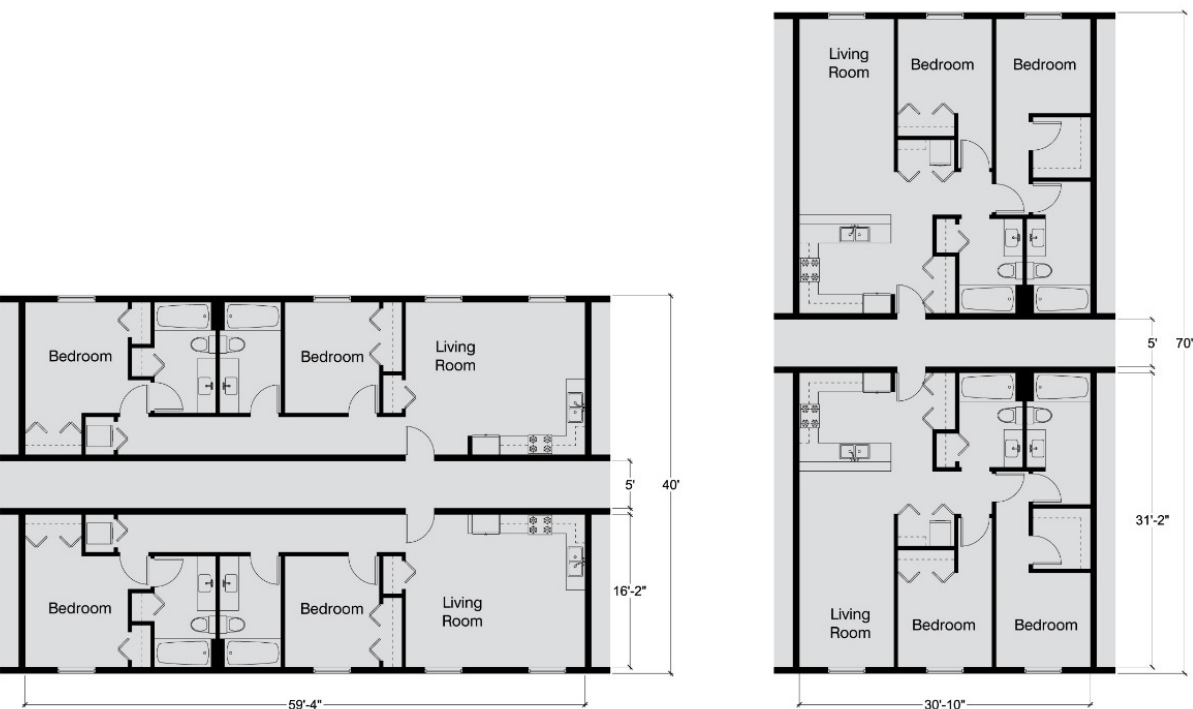
Figure 2. Possible Units in 40 ′ Wide and 70 ′ Wide Floor